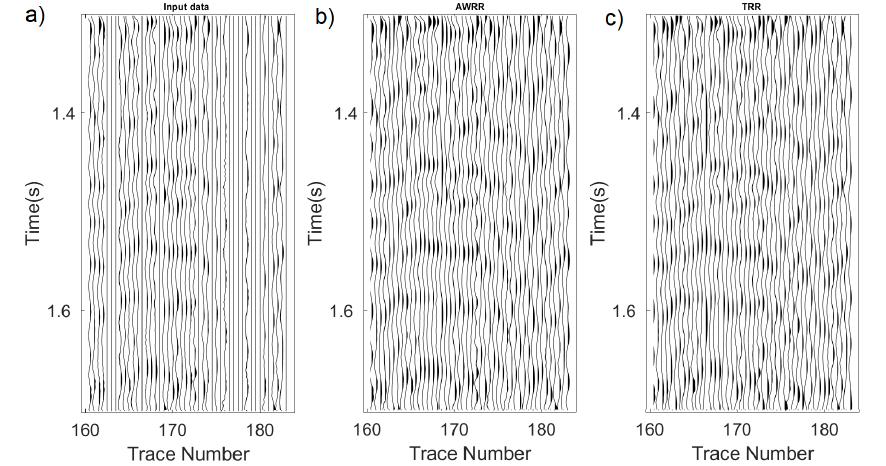
Figure 17. Zooming area of Figure 16 from time 1.35 (s) to 1.75 (s) and trace numbers 160 to 190. ( a ) input data, ( b ) TRR result, ( c ) AWRR